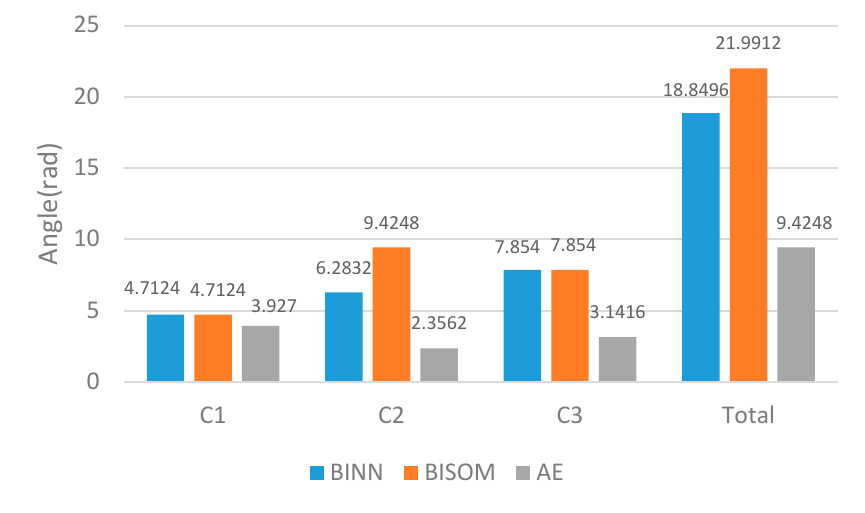
Figure 7. Actual navigation angle diagram of the AUV to the target location.